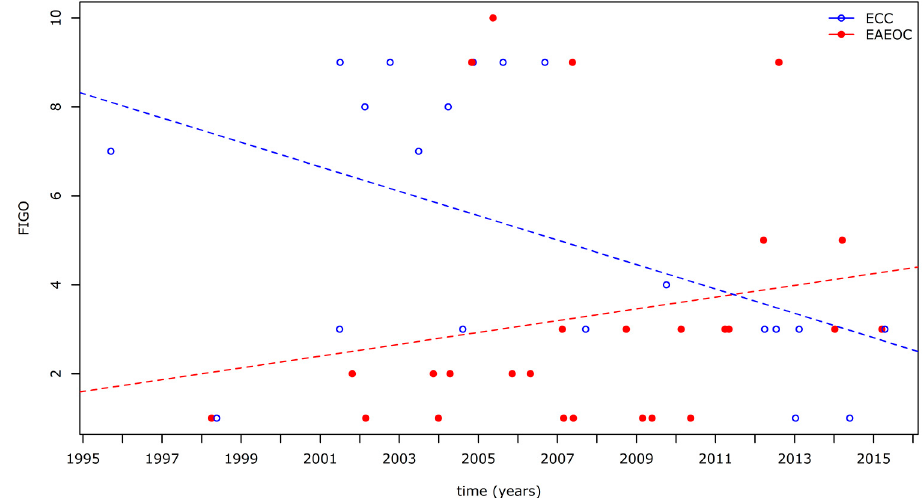
Figure 2. Trends of FIGO stage at diagnosis according to the year of detection for EAEOC and ECC.